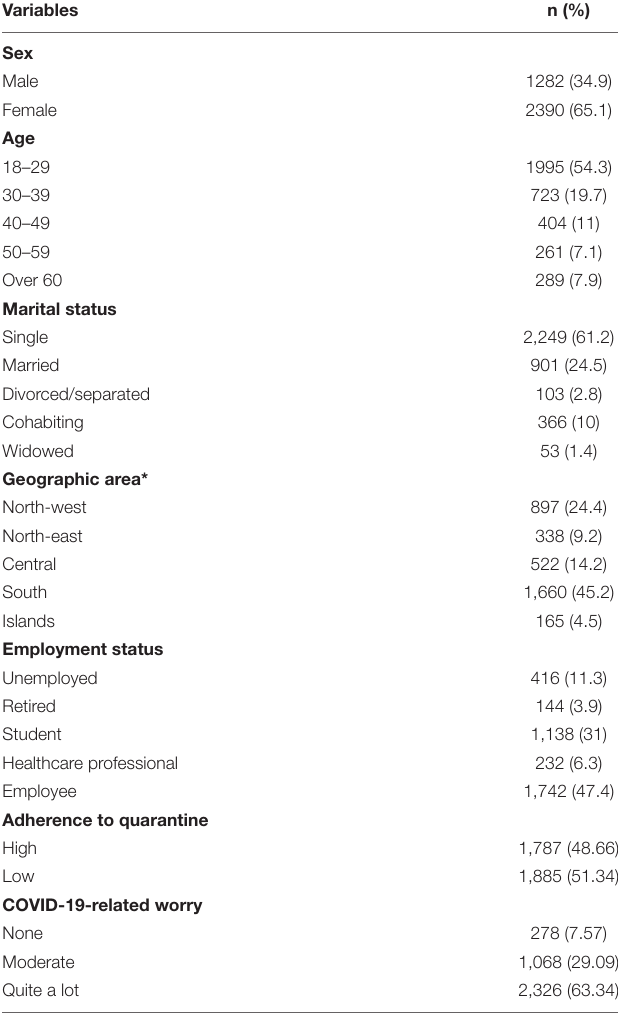
TABLE 1 | Frequencies and percentages of the demographic characteristics of the study sample ( N =